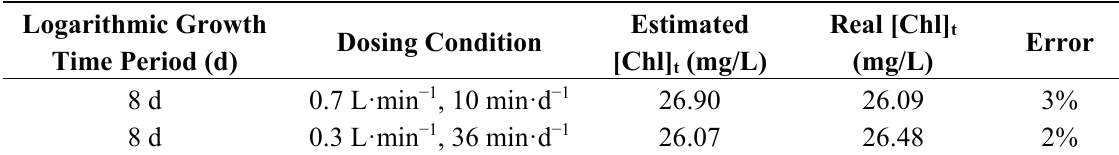
Figure 2. Daily pH values for D. salina cultures supplied periodically with 5% CO 2 . There are two pH values for each day, a higher one and a lower one, representing the pH values before and after CO 2 dosing, respectively. Table 2. Comparisons between estimated final concentrations of chlorophyll and real values for D. salina cultures with different dosing